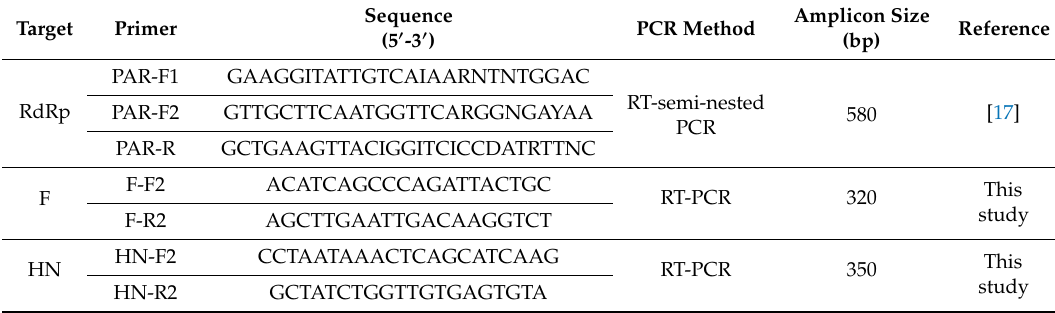
Table 1. Information regarding the primers for RT-semi-nested PCR and